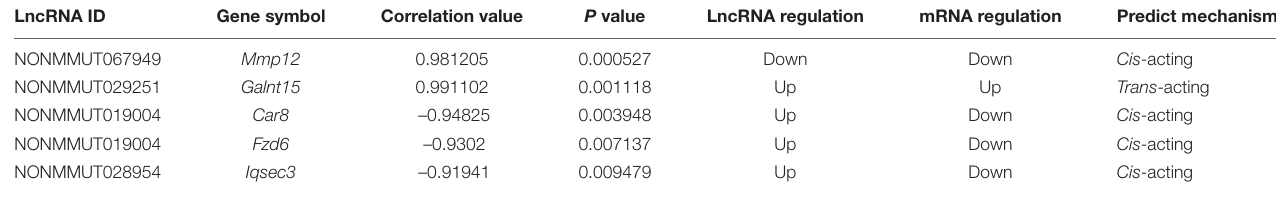
TABLE 4 | Differentially expressed LncRNA and predicted target